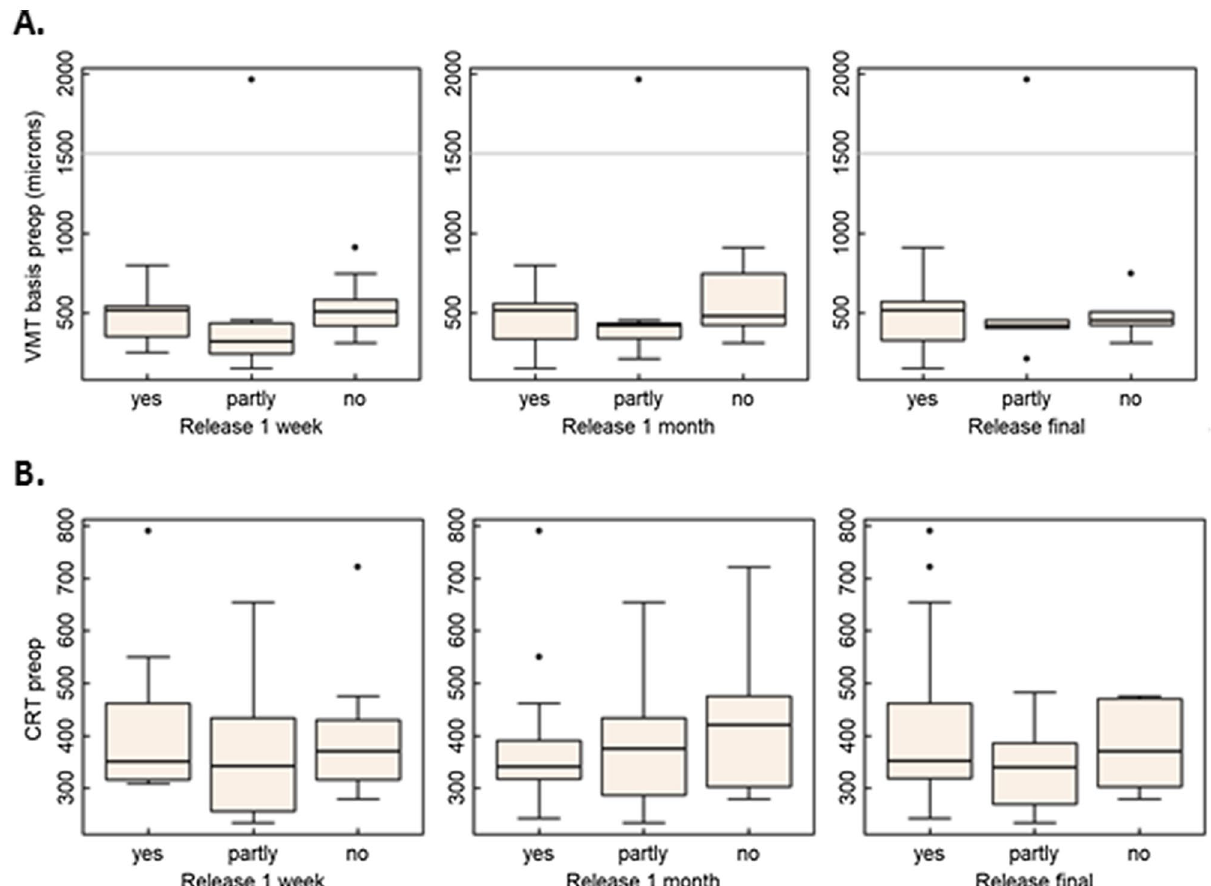
Figure 2. Association of VMT release with VMT Basis and CRT. Boxplots showing the lack of association between VMT release and VMT basis (µm). Grey lines indicate the threshold of 1500 µm. All VMT basis values except for one were clearly below this threshold ( A ). Boxplots showing the lack of association between CRT (µm) and VMT release ( B ).